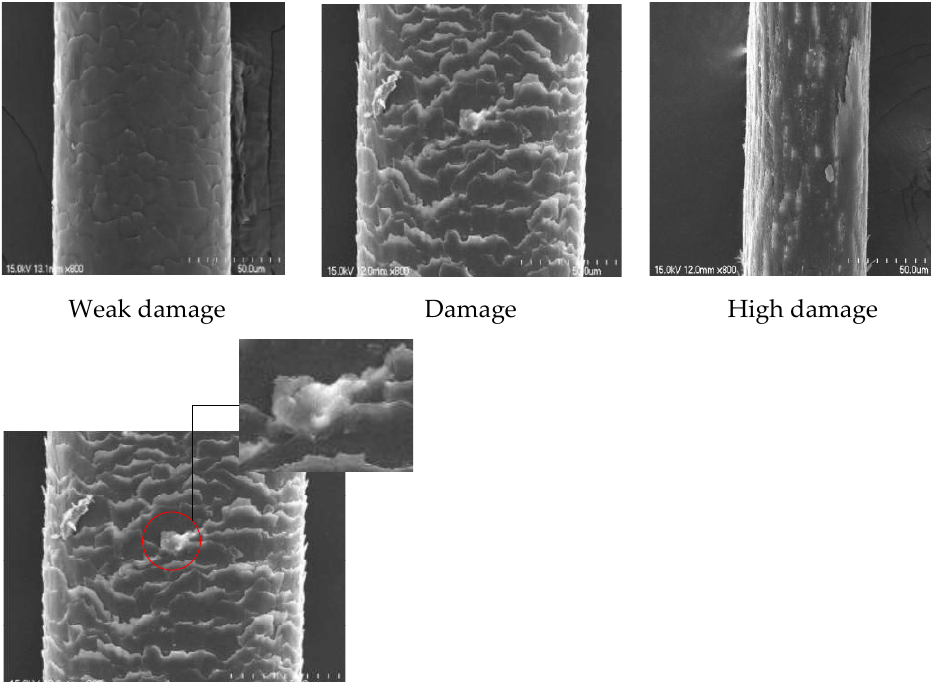
Figure 1. Image of degree of hair damage under SEM microscope × 800; from left to right: damage, high damage, and weak damage. The bottom image shows damaged cuticle layers.